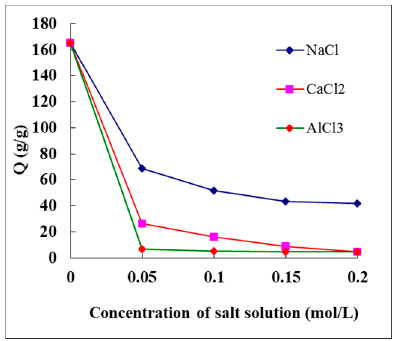
Figure 4. Water absorbency of hydrogels in salt solutions.